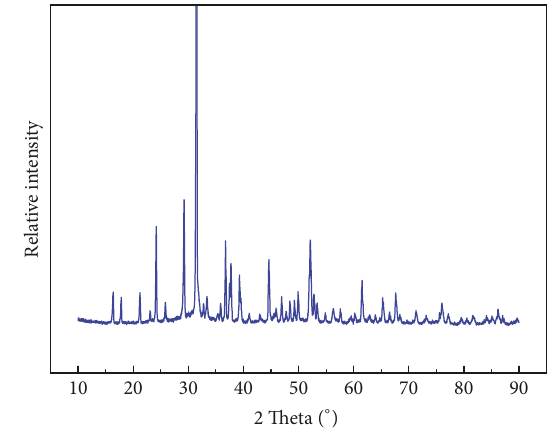
Figure 7: XRD results of experimental slag